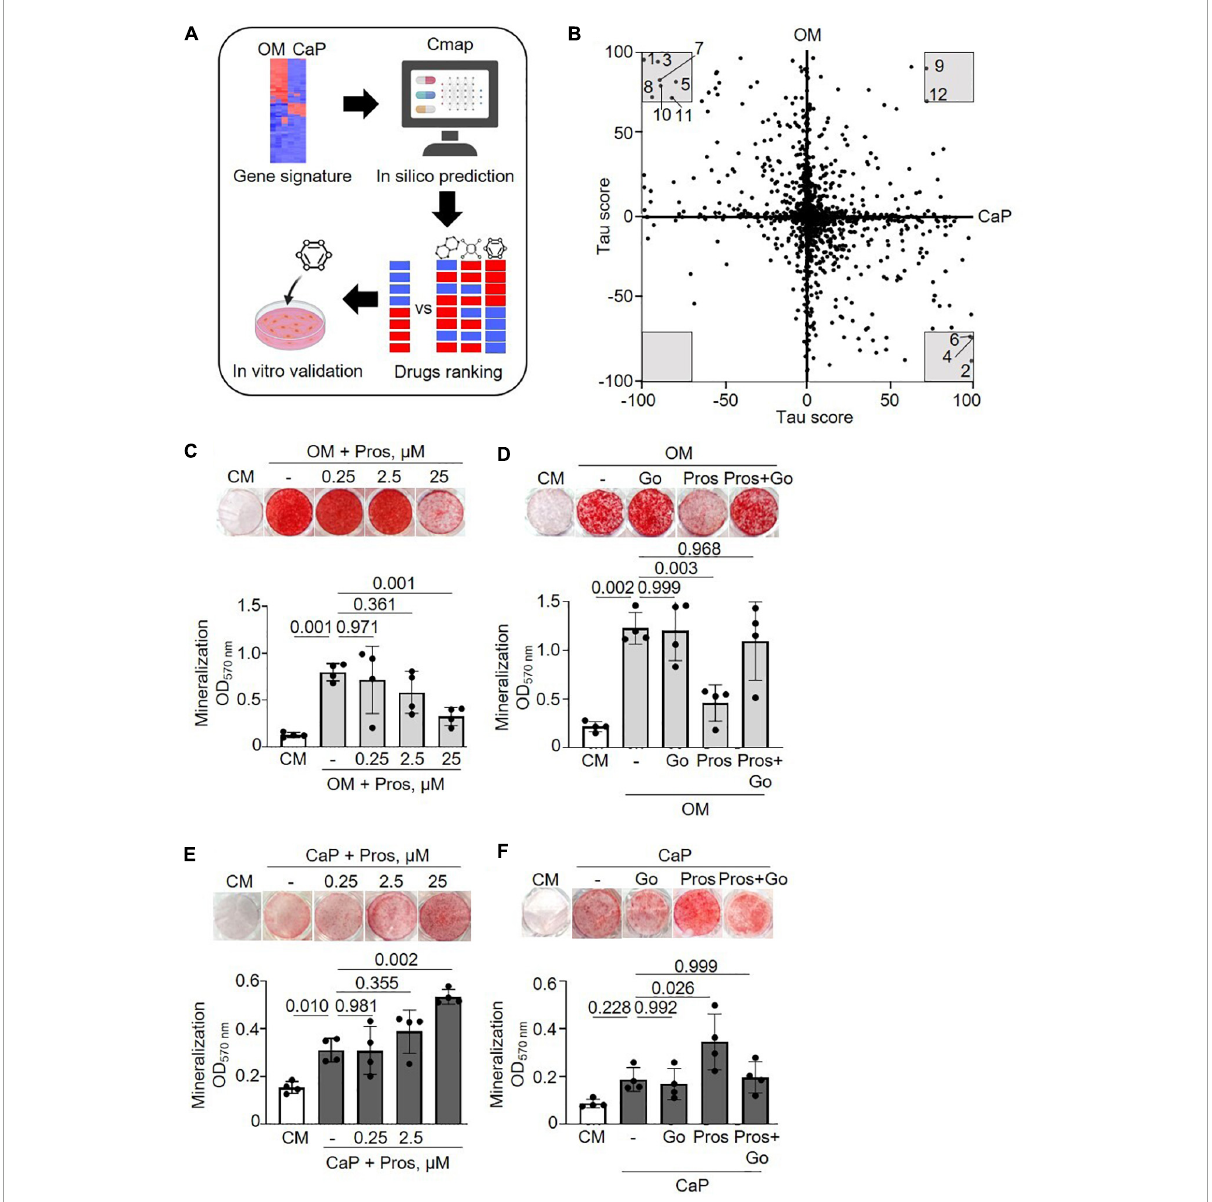
FIGURE4 Drug repurposing of osteogenic medium (OM) and calcium phosphate (CaP) gene signatures. (A) Scheme of the method. Created with https://Biorender.com (B) Scatter plot with predicted effects of drugs on OM and CaP-induced calcification. Gray area–drugs with predicted tau score < or > 70. 1: PD-184352, 2: Prostratin, 3: Fluticasone, 4: Ingenol, 5: L-690330, 6: Phorbol 12-myristate 13-acetate (PMA), 7: Halometasone, 8: Sunitinib, 9: MLN-2238, 10:Hydrocortisone, 11: Benzatropine, 12: Puromycin. (C,D) Effect of the protein kinase C (PKC) activator prostratin (Pros) and the PKC inhibitor Go6983 (Go) in OM and (E,F) in CaP-calcified immortalized vascular smooth muscle cells (iSMCs). iSMCs were cultured in control medium (CM) and OM for 14 days or CaP for 7 days with different concentrations of prostratin (0.25, 2.5, and 25 µ M). Go (100 nM) was combined with 25 µ M prostratin. Representative images of extracellular matrix mineralization (top) detected by alizarin red S staining and quantification of eluted staining (bottom). n = 4–5. C-H, DMSO (1:1,000) was used as solvent control in CM, OM, and CaP groups. Error bars indicate ± SD. Each n indicates an independent replicate. One-way ANOVA with Dunnett’s post hoc